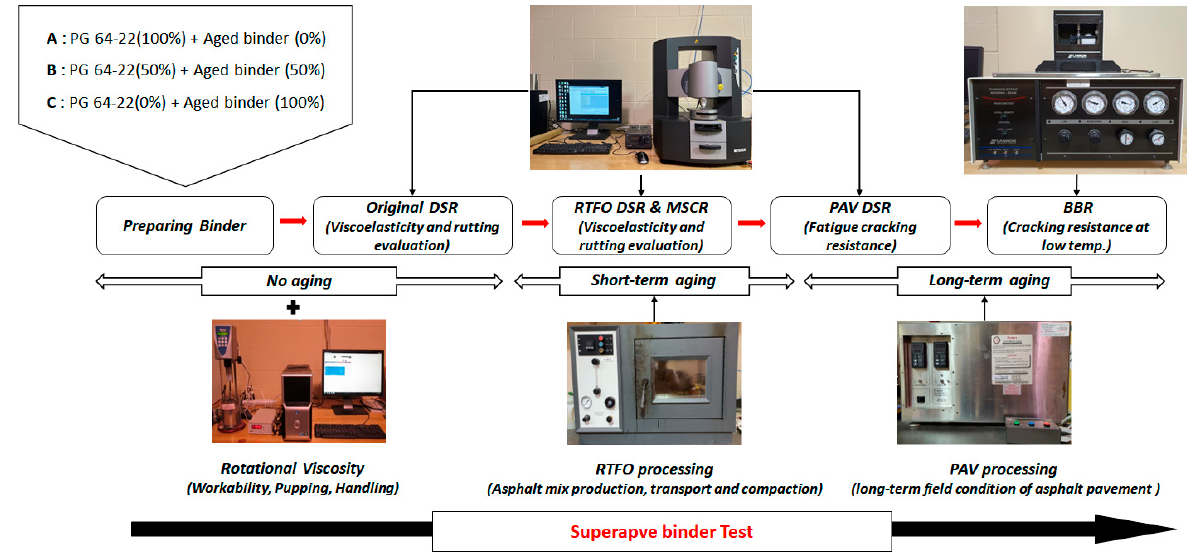
Figure 3. Superpave binder test procedure.